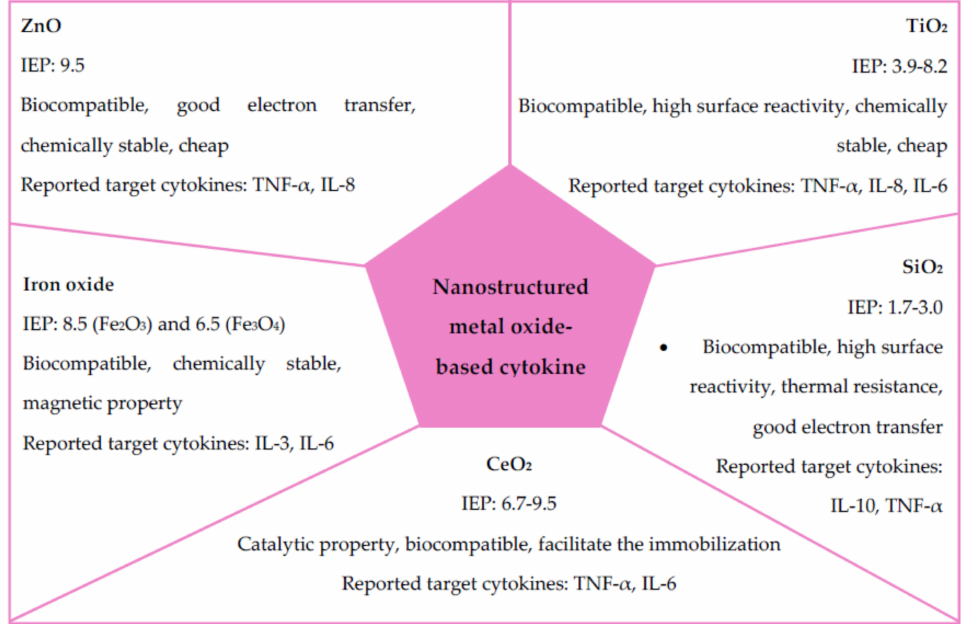
Figure 4. Representative metal oxide nanomaterials that have been used for the development of cytokines biosensors (IEP, isoelectric